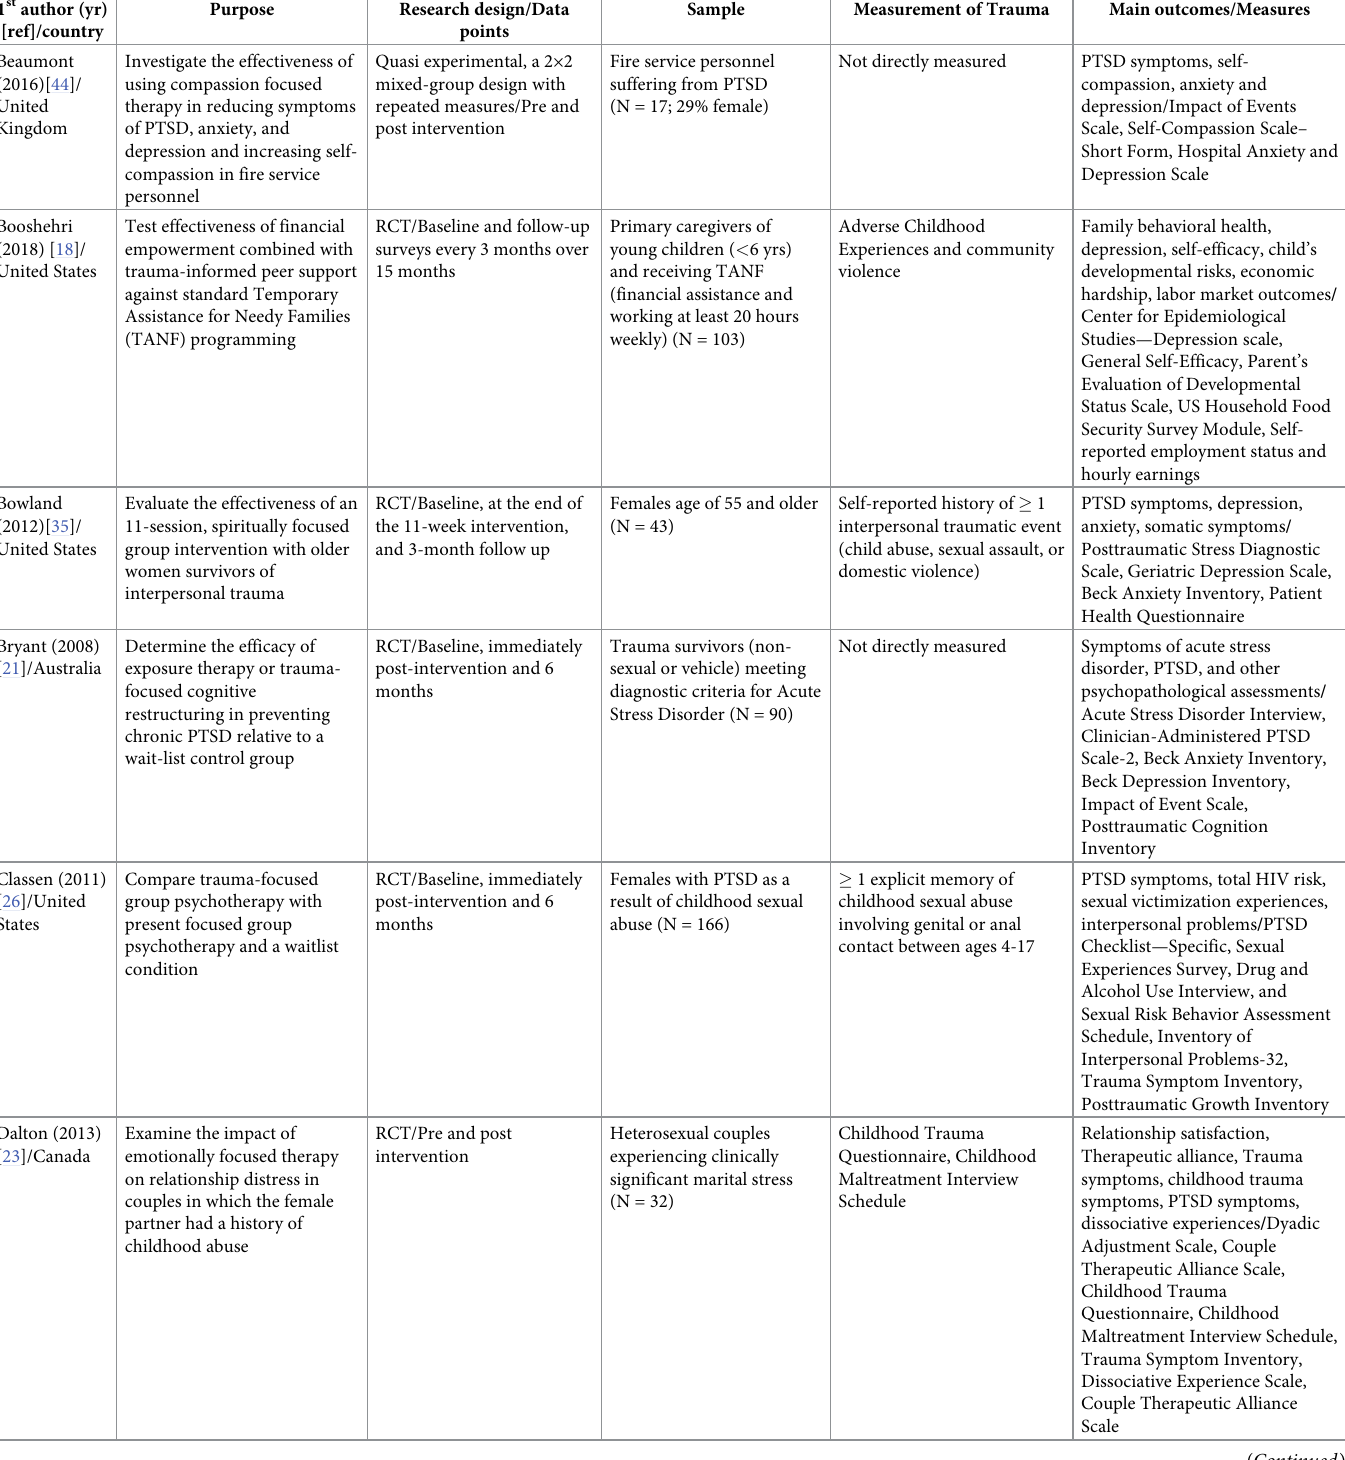
Table 1. Characteristics of the studies included in the